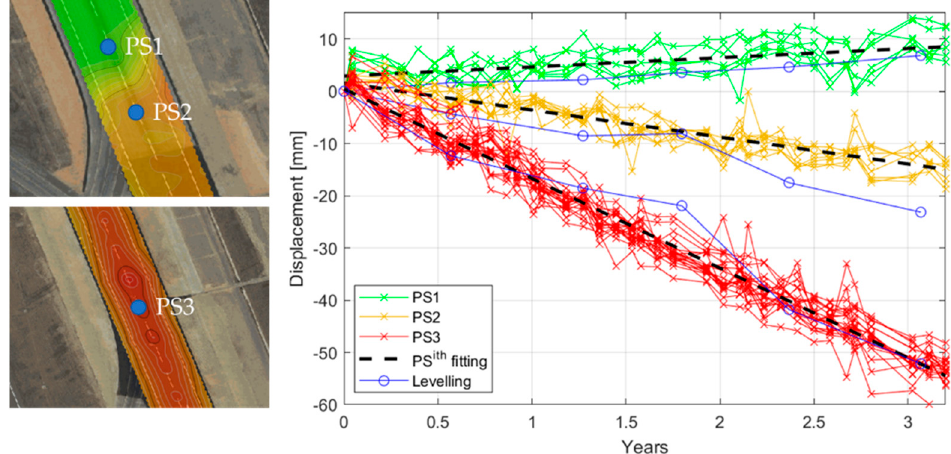
Figure 7. Deformation time series for three points related to low, intermediate, and severe displacement conditions .